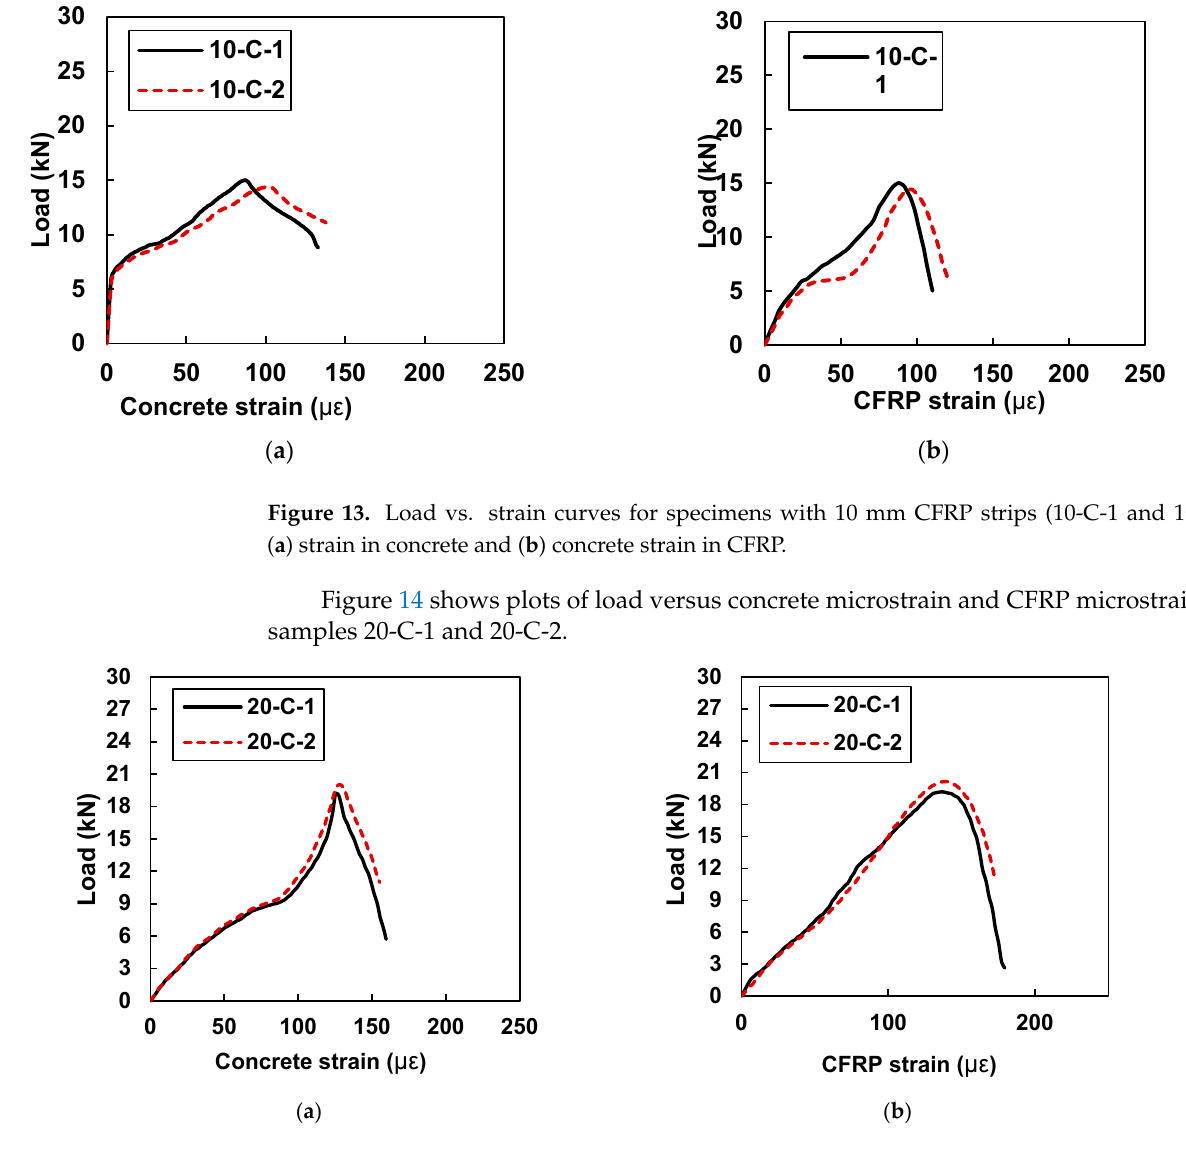
Figure 14. Load vs. strain curves for specimens with 20 mm CFRP strips (20-C-1 and 20-C-2): ( a ) strain in concrete and ( b ) concrete strain in CFRP.